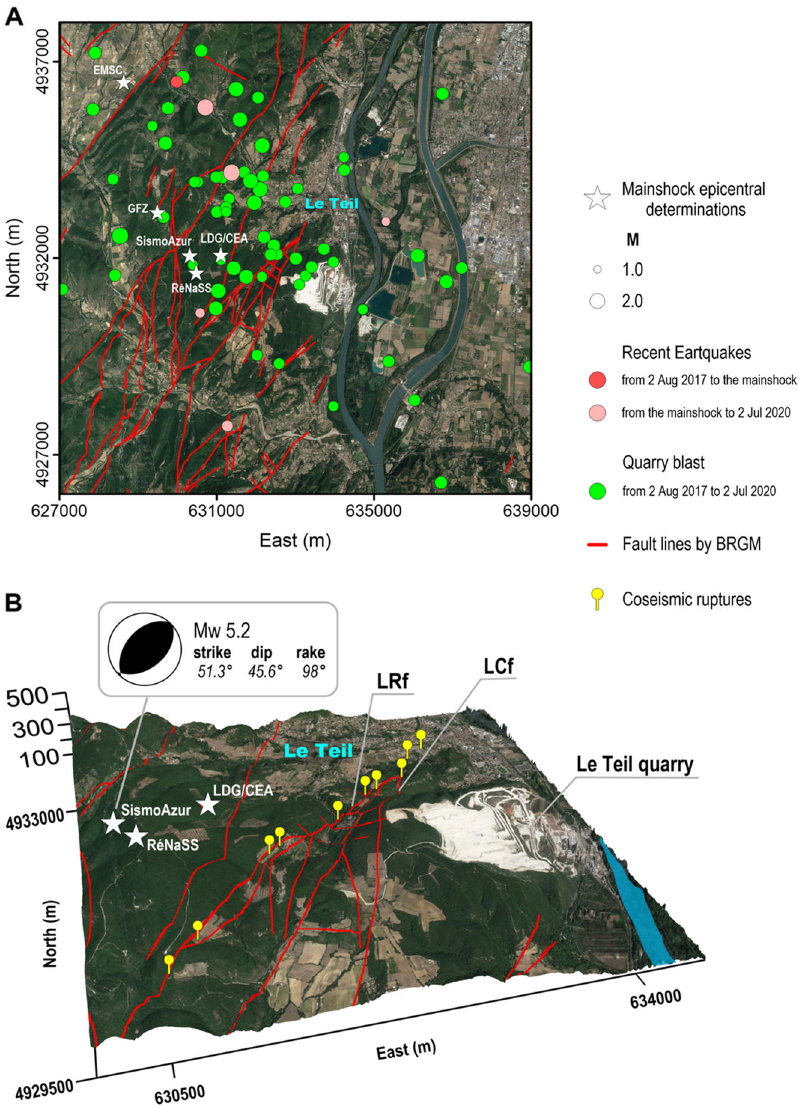
Fig. 1 The 2019 Le Teil earthquake. a Map showing distinct locations of the 2019 earthquake (Table 1), quarry blasts and earthquakes from the RéNaSS catalog (https://renass.unistra.fr/recherche; last accessed April 2020), and the main geological lineaments 12 . b Perspective view with indication of the La Rouviere (LRf) and La Chade (LCf) faults, and coseismic ground ruptures 18 . The mechanism from SismoAzur (Table 1) is also reported. Both images are as of August 25,